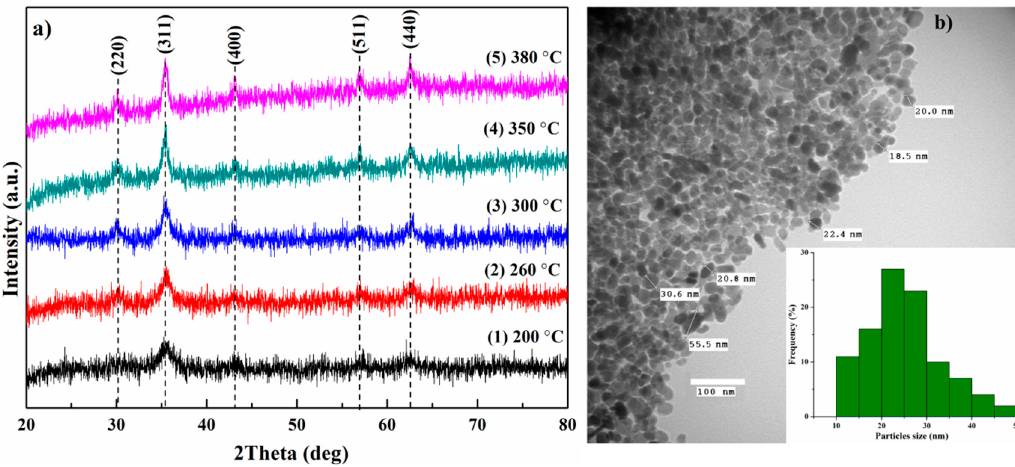
Figure 1. ( a ) XRD patterns of the samples synthesized at different reaction temperatures and ( b ) TEM micrograph of magnetite nanoparticles synthesized at 380 °C. The inset shows the histogram of particle size distribution.